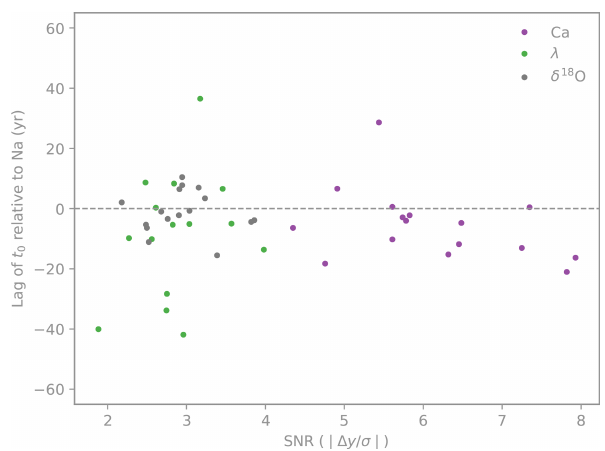
Figure A2. Lag relative to the transition onset in Na + vs. SNR in the respective parameters for the NGRIP data. None of the param- eters show a systematic connection of the inferred leads and lags with their